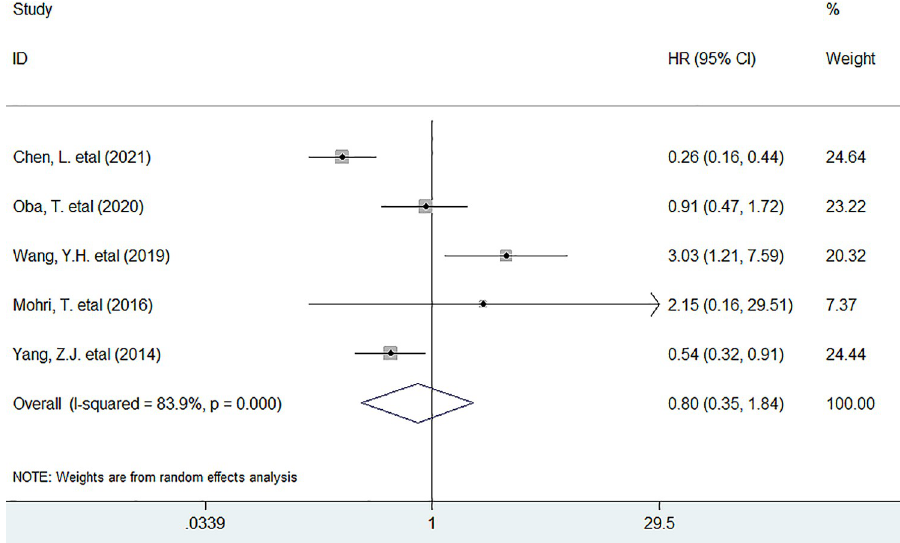
Fig 4. Forest plots describing HRs of the association between decreased baseline PNI and DFS in breast cancer patients. HR: hazard ratio; PNI, prognostic nutritional index; DFS, disease–free survival.